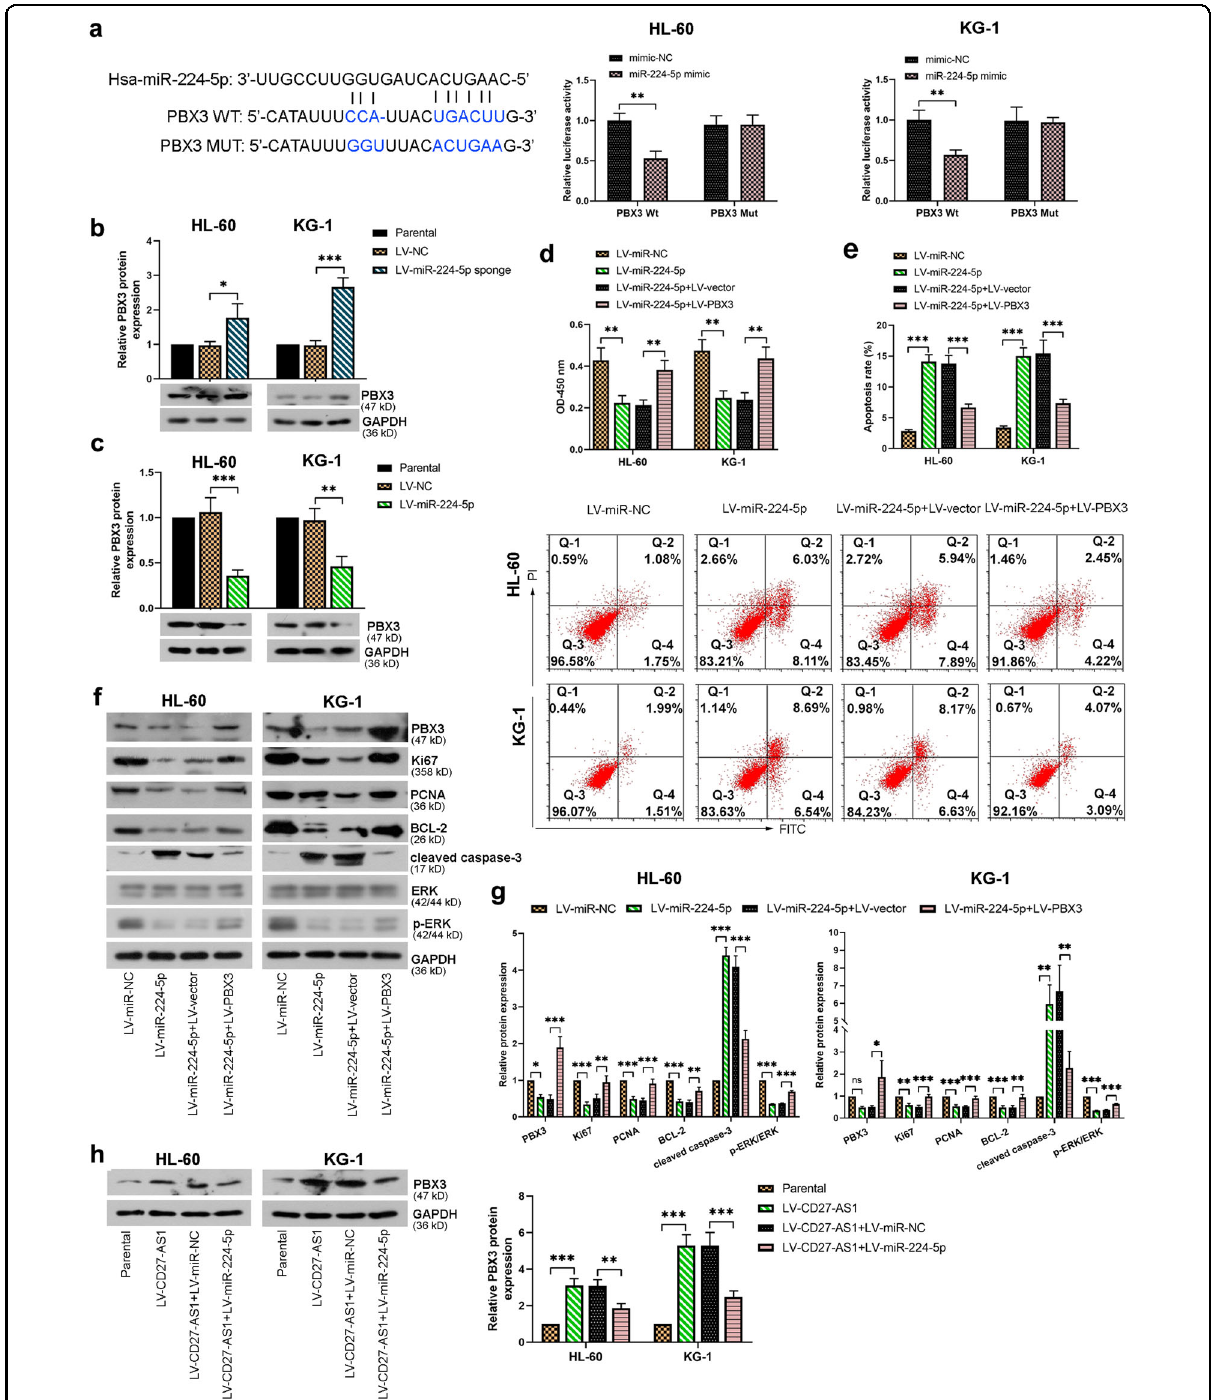
Fig. 7 MiR-224-5p binds to PBX3 to regulate AML cell activity. a Binding sequences between miR-224-5p and PBX3 were shown, and their binding effects were evaluated using dual luciferase reporter assay. b , c Western blotting was used to show relative protein levels of PBX3 in HL-60 and KG-1 cells infected with LV-miR-224-5p sponge and LV-miR-224-5p. HL-60 and KG-1 were then co-infected with the LV-miR-224-5p and LV-PBX3. d , e CCK-8 and fl ow cytometry was performed to detect the cell viability and cell apoptosis, respectively. f Relative protein levels of PBX3, Ki67, PCNA, BCL-2, cleaved caspase-3, ERK, and p-ERK in two co-infected AML cells were evaluated using western blotting. g Quanti fi ed fi gures of above protein levels from western blotting. h PBX3 protein expression was assessed in HL-60 and KG-1 cells after co-infection of LV-CD27-AS1 and LV-miR-224-5p by western blotting, with their quanti fi cation. N = 3. Data were shown as means ± S.D. * P < 0.05, ** P < 0.01, *** P < 0.001, and ns = no signi fi